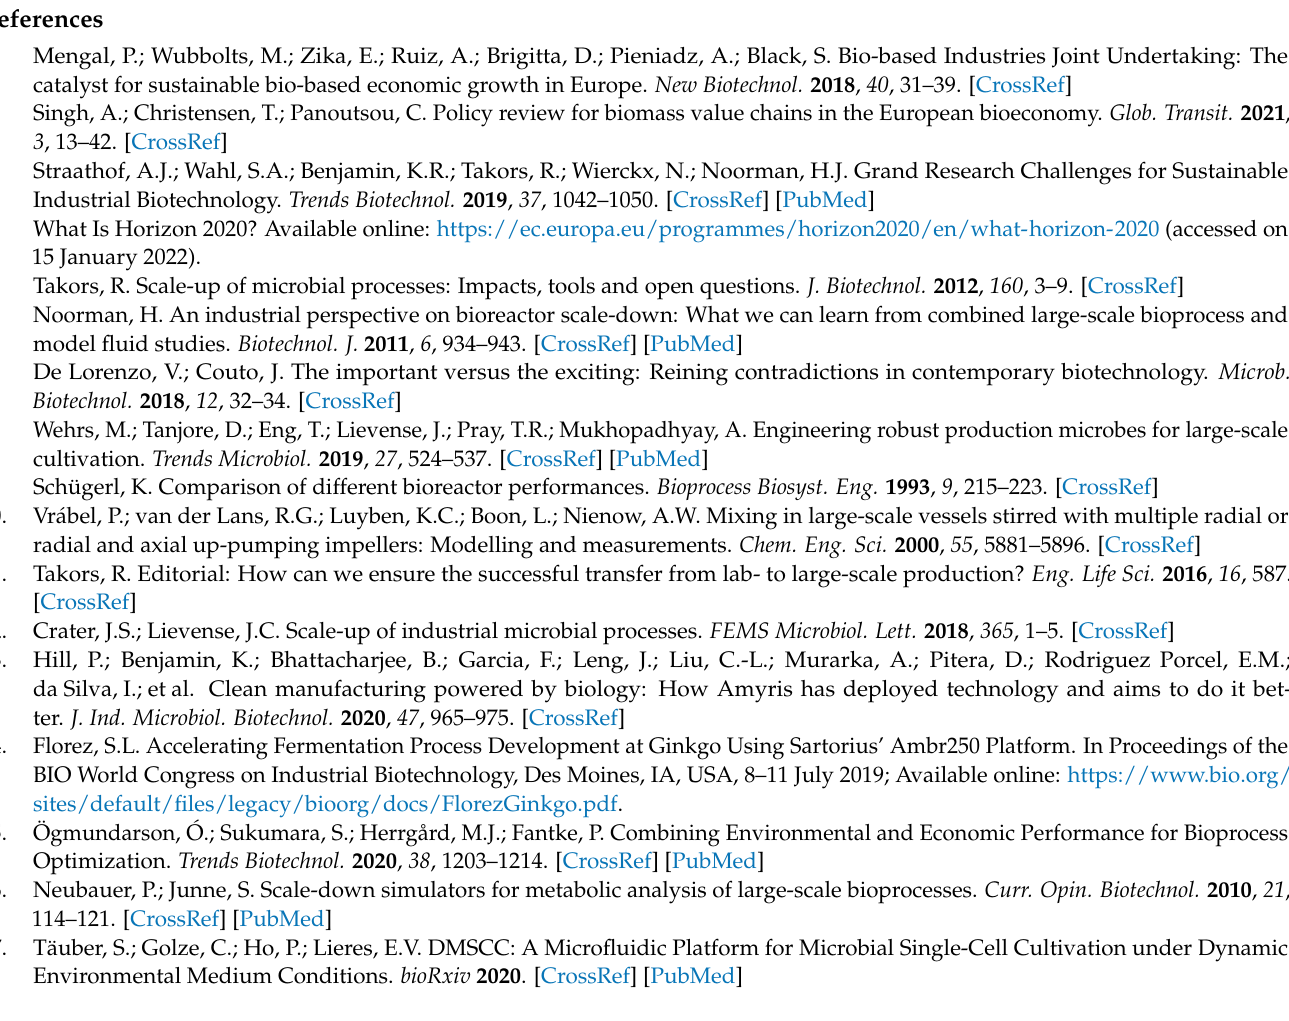
All values represent means ± standard deviation (s.d.) of three biological replicates. n.s., not